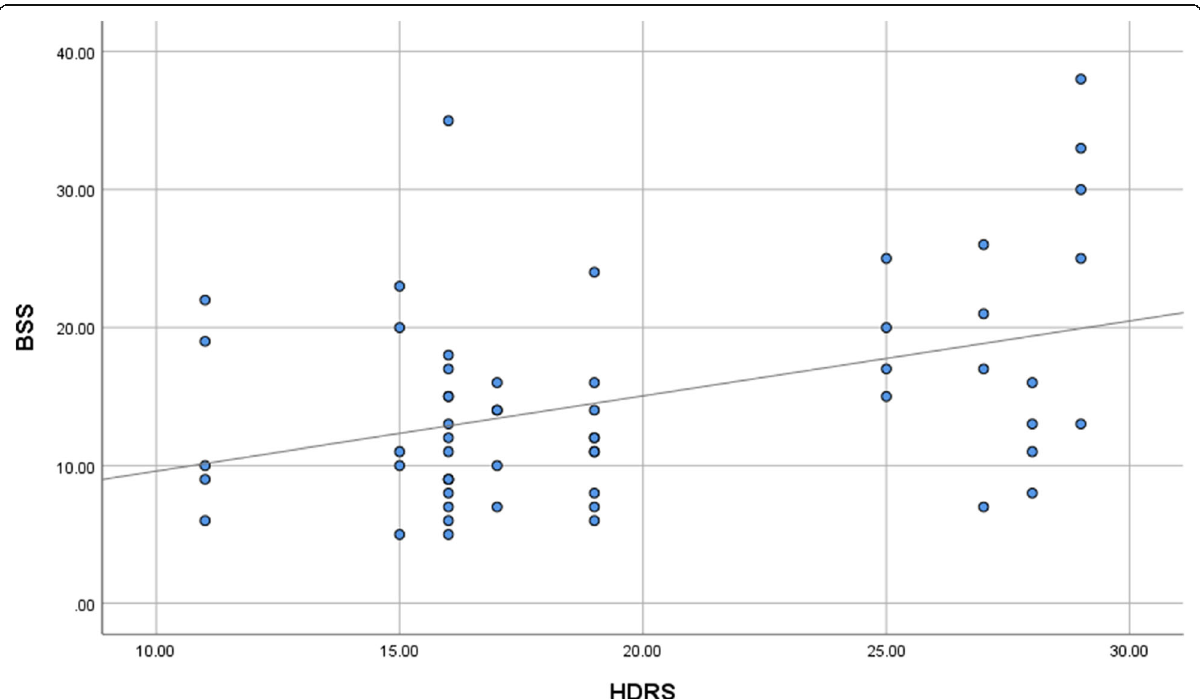
Fig. 4 Correlation between Hamilton Depression Rating Scale (HDRS) and Beck Scale for Suicidal Ideation (BSS)